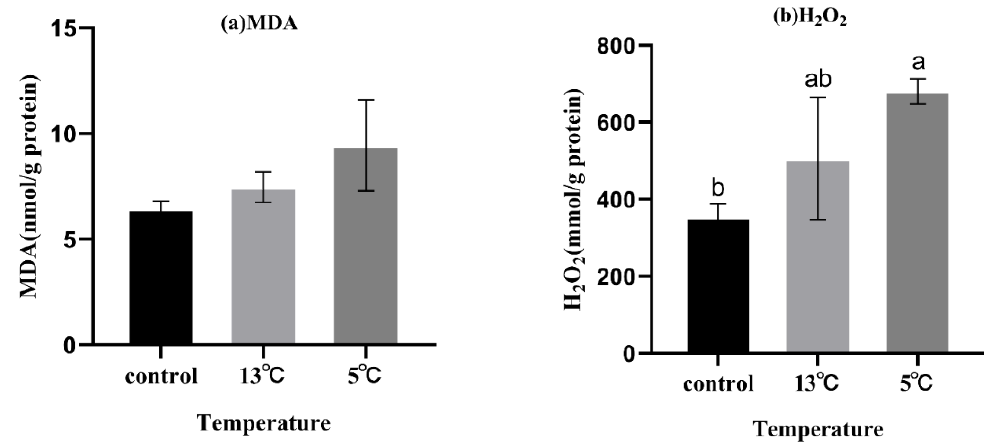
Figure 1. Effect of upwelling on MDA and H 2 O 2 content in the leaves of K.obovata. ( a ) MDA, malondialdehyde activity; ( b ) H 2 O 2 , hydrogen peroxide. Values are presented as mean ± SD, and bars with different letters indicate significant differences ( p < 0.05).